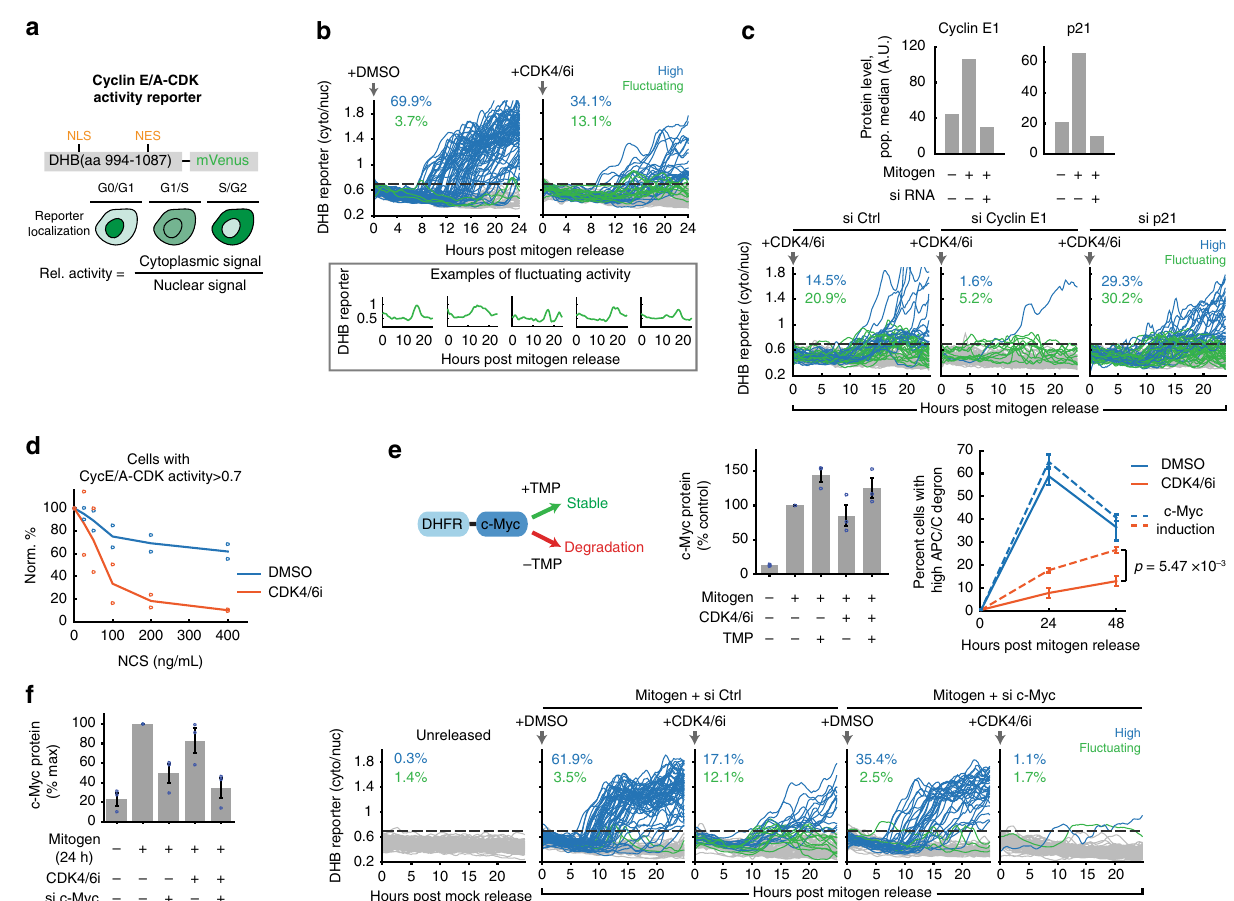
Fig. 2 Cells without CDK4/6 activity exhibit slower and fl uctuating increases in cyclin E-CDK2 activity. a DHB-based cyclin E/A-CDK activity reporter. b Single-cell traces of cyclin E/A-CDK activity after mitogen release with or without 1 µ M CDK4/6 inhibitor (100 cells plotted; 2782 and 8548 cells total for DMSO and CDK4/6 inhibitor; 1 of n = 2 biological replicates). Activity baseline at time 0 is determined to be at most 0.7 (dashed horizontal line). Blue: >0.7 at last time point. Green: <0.7 at last time point, exceeded 0.7 at some point between 8 and 24 h. Gray: rest of the cells. Bottom: Examples of fl uctuating cyclin E/A-CDK activity. c Top: immuno fl uorescence validation of cyclin E1 and p21 knockdown. Bottom: effect of knockdown on cyclin E/A- CDK activity in cells treated with CDK4/6 inhibitor. Traces classi fi ed the same way as ( b ) (100 cells plotted; 2958, 3707, 3113 cells for si Ctrl, si Cyclin E1, and si p21; 1 of n = 2 biological replicates). d Cells were treated with neocarzinostatin (NCS) for 15 min, and then mitogen released for 24 h. Percent cells with high cyclin E/A-CDK activity (de fi ned as reporter ratio >0.7) are displayed. Percentages normalized to 0 ng/mL condition. Mean of n = 2 biological replicates. e Cells were stably infected with DHFR-Myc that is unstable until TMP molecule addition. c-Myc protein levels were induced to ~50% above control after adding 10 µ M TMP at the time of mitogen release. Cells fi xed at 24 and 48 h after mitogen release. c-Myc protein level measured via immuno fl uorescence. Drugs refreshed every 24 h. Mean ± SEM from three biological replicates; p value calculated over the 48 h CDK4/6i condition using a two-sided, two-sample t test. f Left: immuno fl uorescence of c-Myc knockdown validation (mean ± SEM from three biological replicates). Right: cyclin E/A- CDK activity after mitogen release in MCF-10A (100 cells plotted, 579, 3446, 3904, 3935, 3767 total cells for unreleased, si Ctrl + DMSO, si Ctrl + CDK4/6 inhibitor, si c-Myc + DMSO, and si c-Myc + CDK4/6 inhibitor, respectively), 1 of n = 3 biological